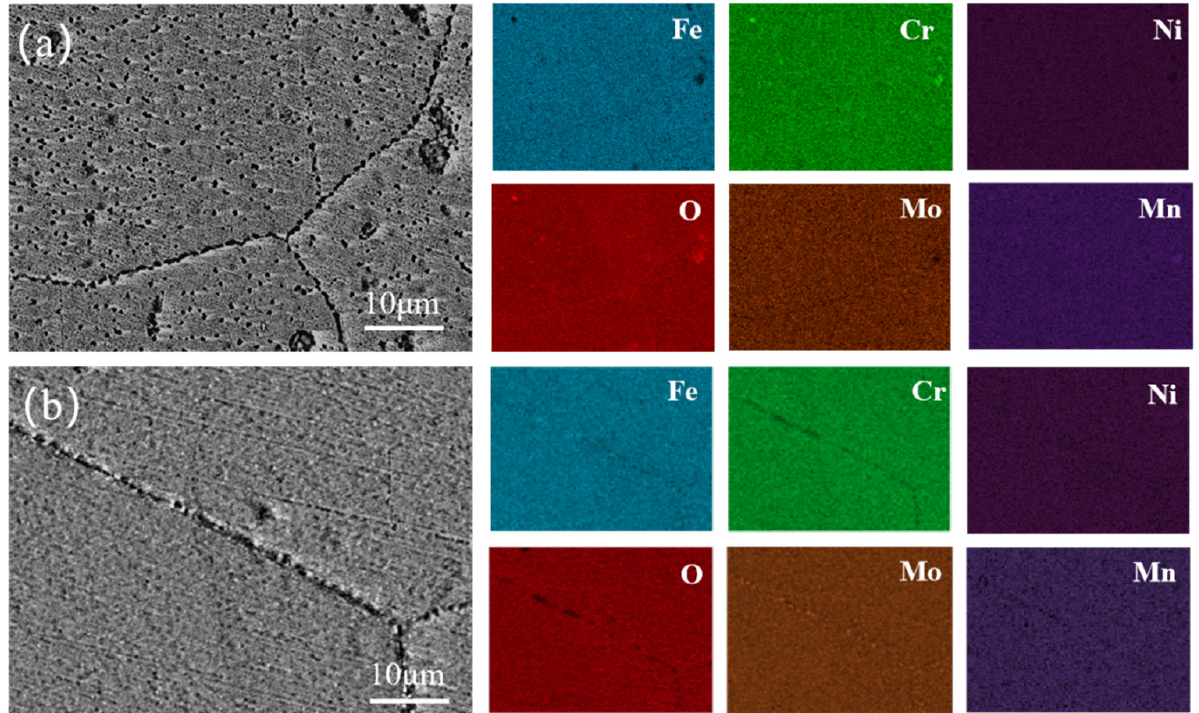
Figure 3. The SEM surface morphologies and EDS analysis results of the 254SMO–0B ( a ) and 254SMO–40B ( b ) samples after oxidation at 900 °C for 30min.